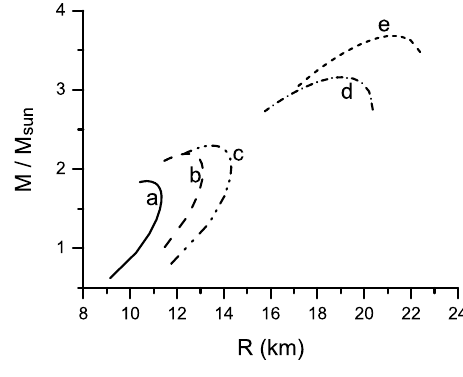
Figure 2. Relationship between the ratios of the star’s to the sun’s masses and the star’s radius under the same conditions as those in Fig.